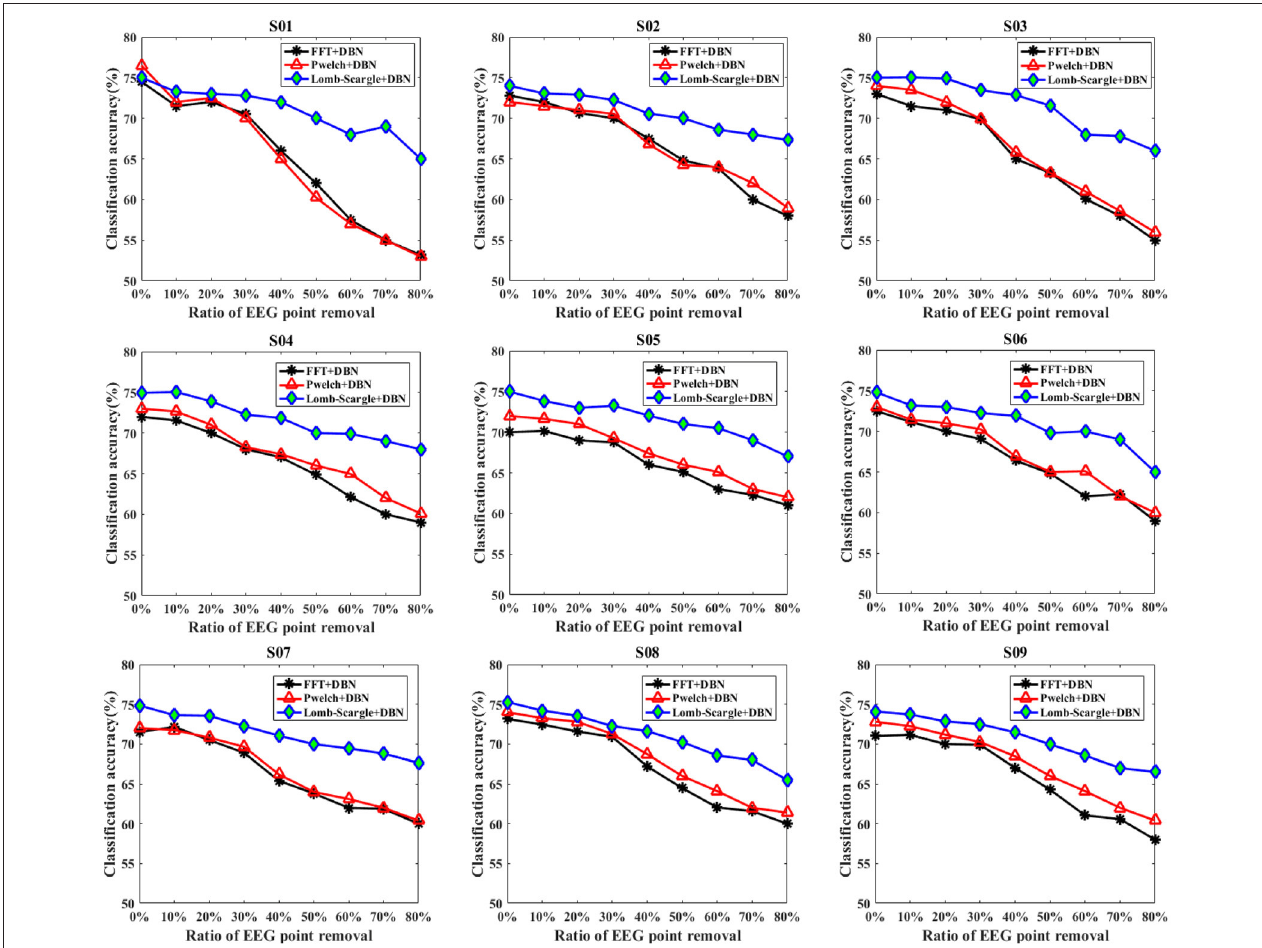
FIGURE 5 | The classification results of the intact EEG and incomplete EEG with various ratios of data point removal (from 10 to 80% with a step of 10%), for the nine subjects (from S01 to S09). Three spectral feature extraction methods were used for comparison: the black lines, red lines and blue lines represent the accuracy of DBN with FFT, Welch and Lomb-Scargle feature extraction,